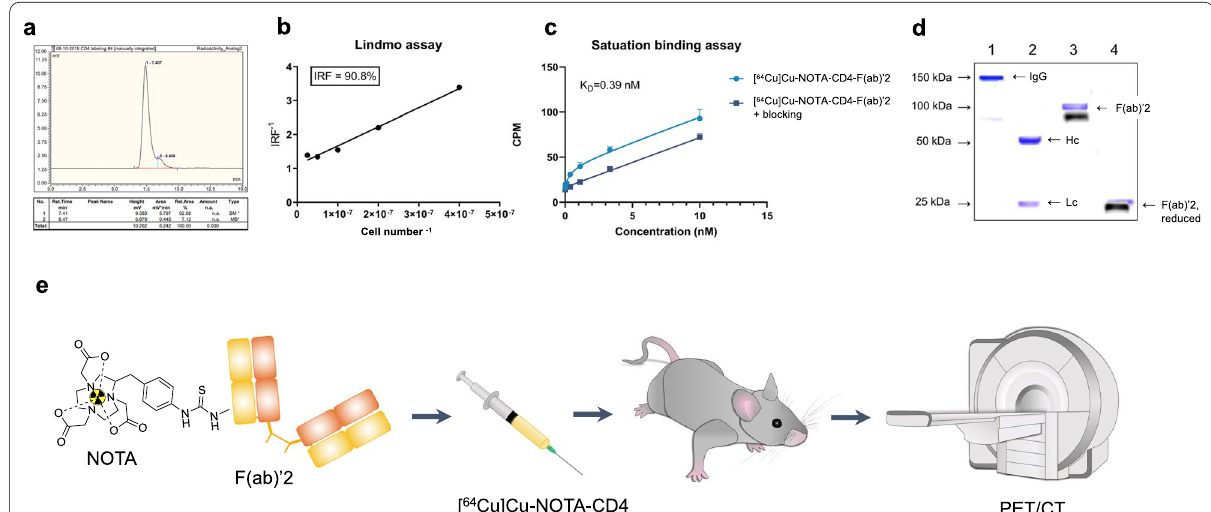
Fig. 1 Development of [ 64 Cu]Cu-NOTA-CD4: a CD4 + T cell targeting PET tracer. a Representative radio-HPLC chromatogram of [ 64 Cu]Cu-NOTA-CD4. b Immunoreactivity of [ 64 Cu]Cu-NOTA-CD4. c K D value of [ 64 Cu]Cu-NOTA-CD4. d Merged and cropped SDS-PAGE of Coomassie staining and radiography of the same gel SDS-PAGE gel. Lane 1: Full-length anti-mouse CD4 antibody (IgG); Lane 2: Full-length anti-mouse CD4 antibody, reduced. Hc: Heavy chain. Lc: Light chain; Lane 3: [ 64 Cu]Cu-NOTA-CD4; and Lane 4: [ 64 Cu]Cu-NOTA-CD4, reduced. e The cyclic chelator NOTA was conjugated to F(ab)’2 fragments of R-anti-mouse CD4 antibodies and radiolabeled with Cu-64. Mice were i.v. injected with [ 64 Cu]Cu-NOTA-CD4 and co-dose prior to PET/CT